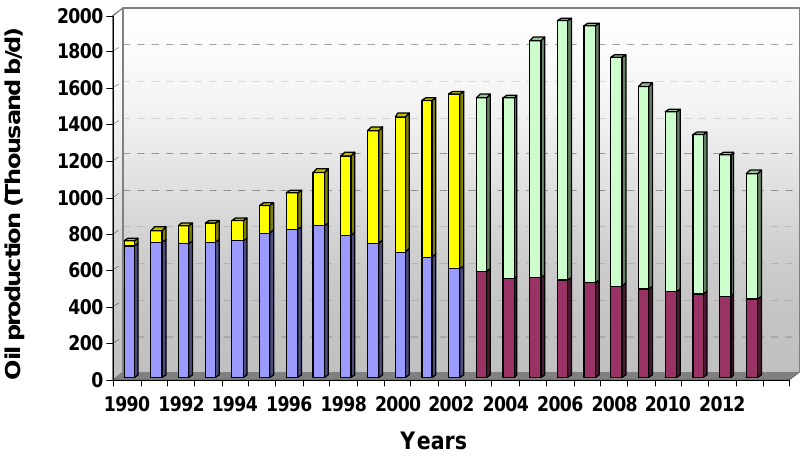
Figure 8. Historic and forecast oil production rates of U.S. GOM shallow and deep water projects (E = Estimated) (From MMS, 2005